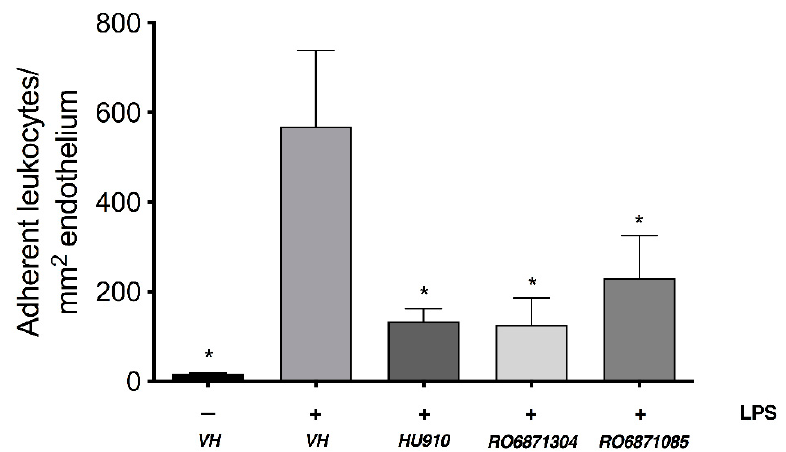
Figure 1. A screen of novel selective CB 2 R agonists to determine the most e ffi cacious ligand in reducing leukocyte-endothelial adhesion in the iridial microcirculation during EIU in BALB / c mice. The bar graph represents the mean number of adherent leukocytes 6 h after intravitreal injection of: Saline (control) + topical vehicle (Tocrisolve, n = 6); lipopolysaccharide (LPS) (250 ng) + topical vehicle (n = 6); LPS + topical HU910 (1.5% w / v ; n = 6); LPS + topical RO6871304 (1.5% w / v ; n = 6); or LPS + topical RO6871085 (1.5% w / v ; n = 6). Data are presented as mean ± SD. One-way ANOVA with Tukey’s for multiple comparisons; * p < 0.05 compared to LPS + vehicle.